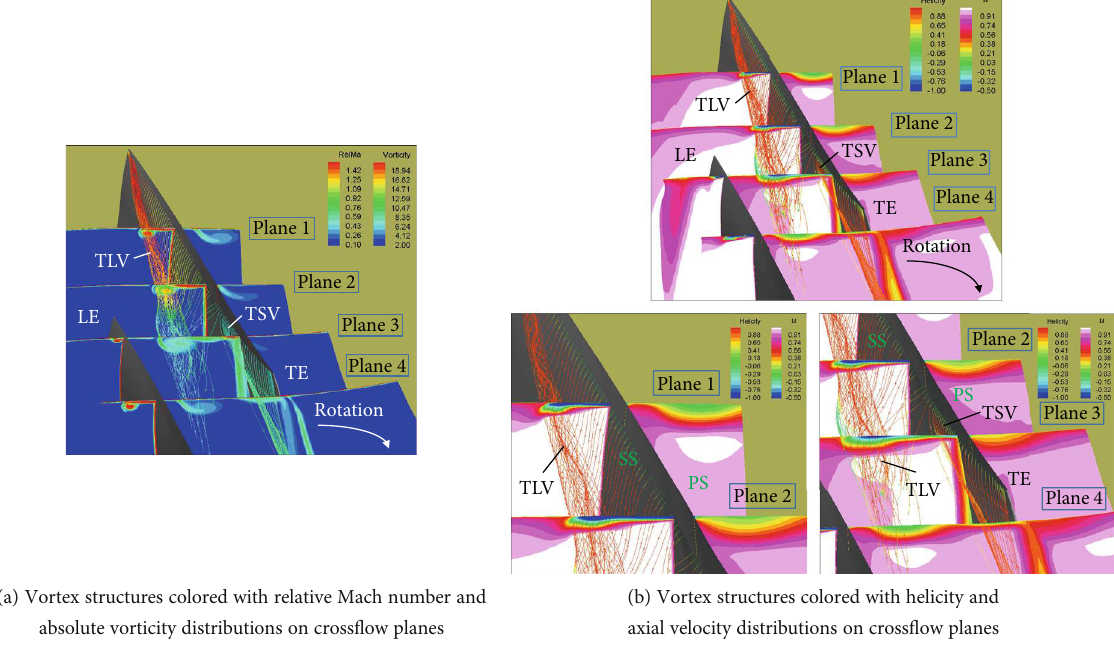
Figure 20: Characteristics of shock-induced vortex stability at near-peak e ffi ciency condition for Rotor 37.